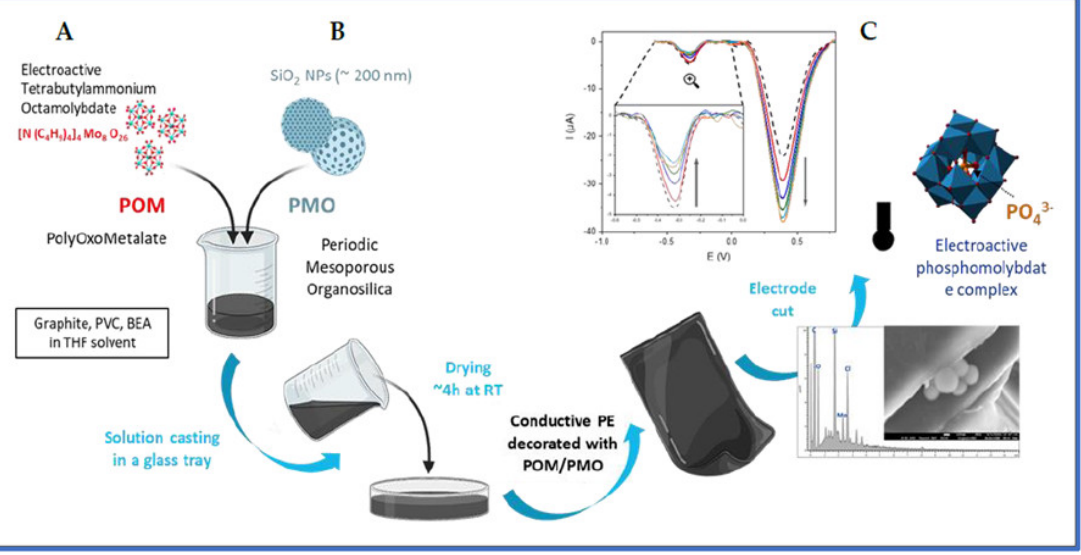
Figure 4. Scheme for the E-sensor preparation for phosphate detection in the two formulations adopted ( A , B ) and signal of enhanced sensitivity measured in presence of DIP ( C ).